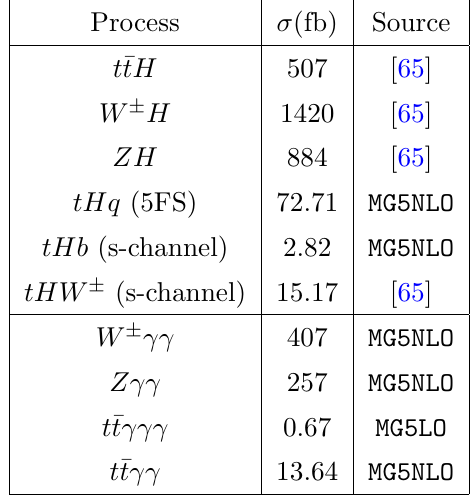
Table 2 . Production cross sections for signal and background